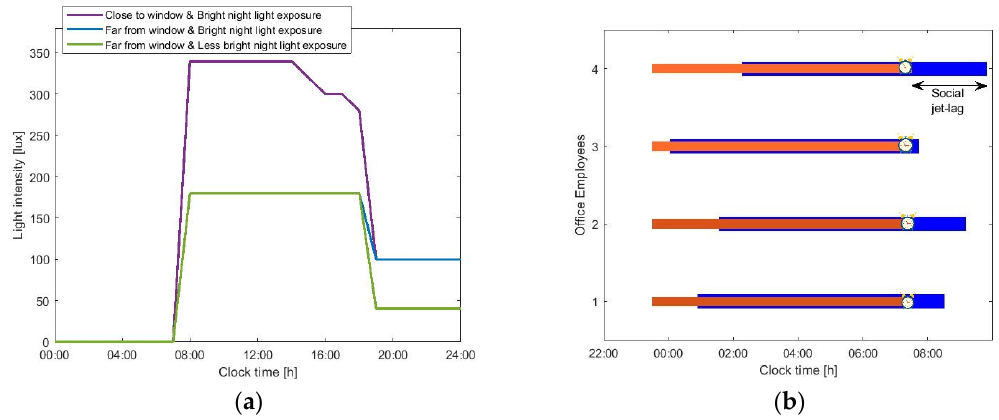
Figure 2. ( a ) Lighting levels representative of typical lighting exposure in the modern era. Light intensity levels of typical activities (watching TV, laptop use) were measured using a BH1750 Digital Light Sensor with an artificial light on (average value 100 lux) and off (average value 40 lux), respectively; ( b ) experienced social jet-lag in modern society, quantified as the time difference between the unconstrained sleep and wake-up times (blue bars) and sleeping and waking up under the constrains of working times (orange bar).